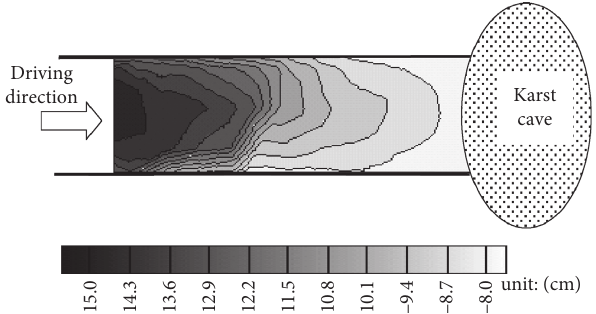
Figure 13: Horizontal displacement of the water-proof rock pillar when the reduction factor F i � 1 . 54.